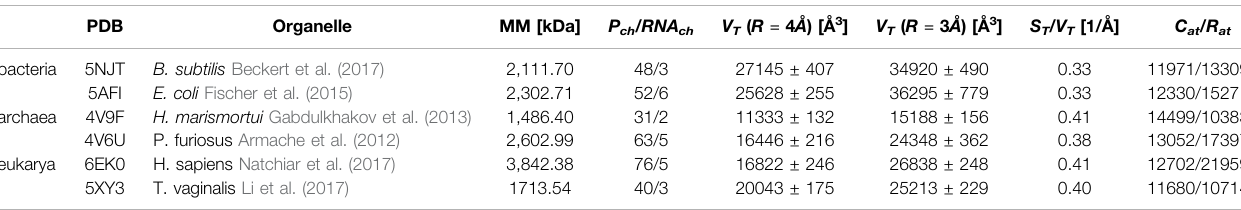
TABLE 1 | Six ribosomal structures considered in our analysis.